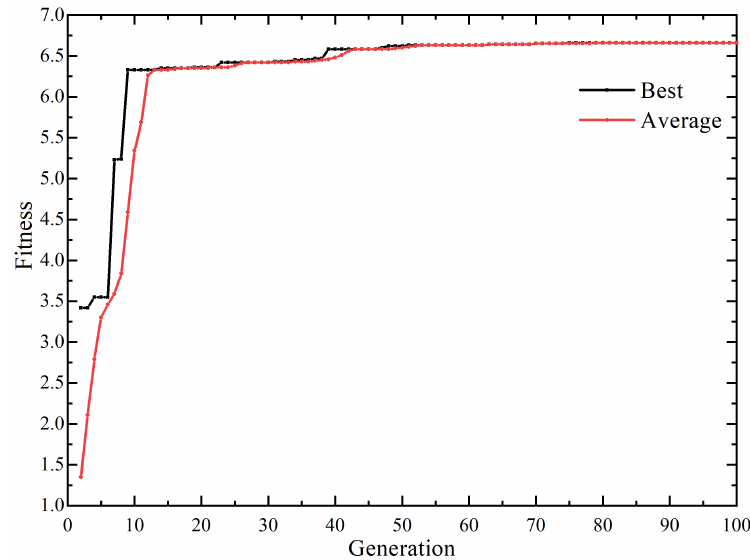
Figure 4. Training process of the GA-BP neural network